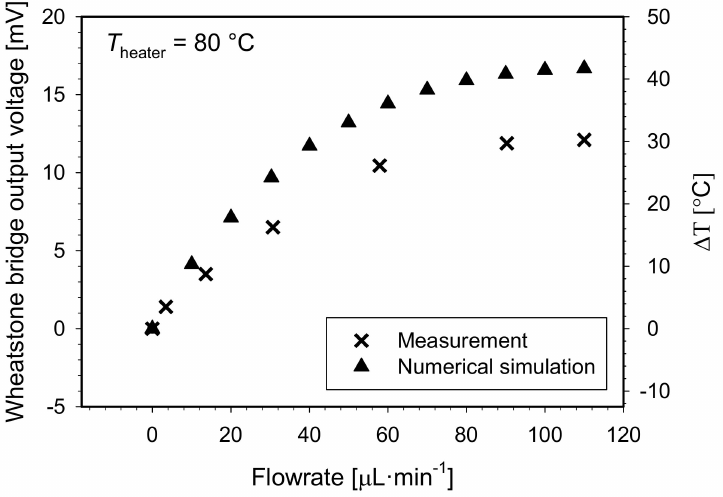
Figure 14. Measured and simulated Wheatstone bridge output signal and differential temperature between both sensor elements vs. flowrate for S-H-S configuration under constant heater tempera- ture regime.